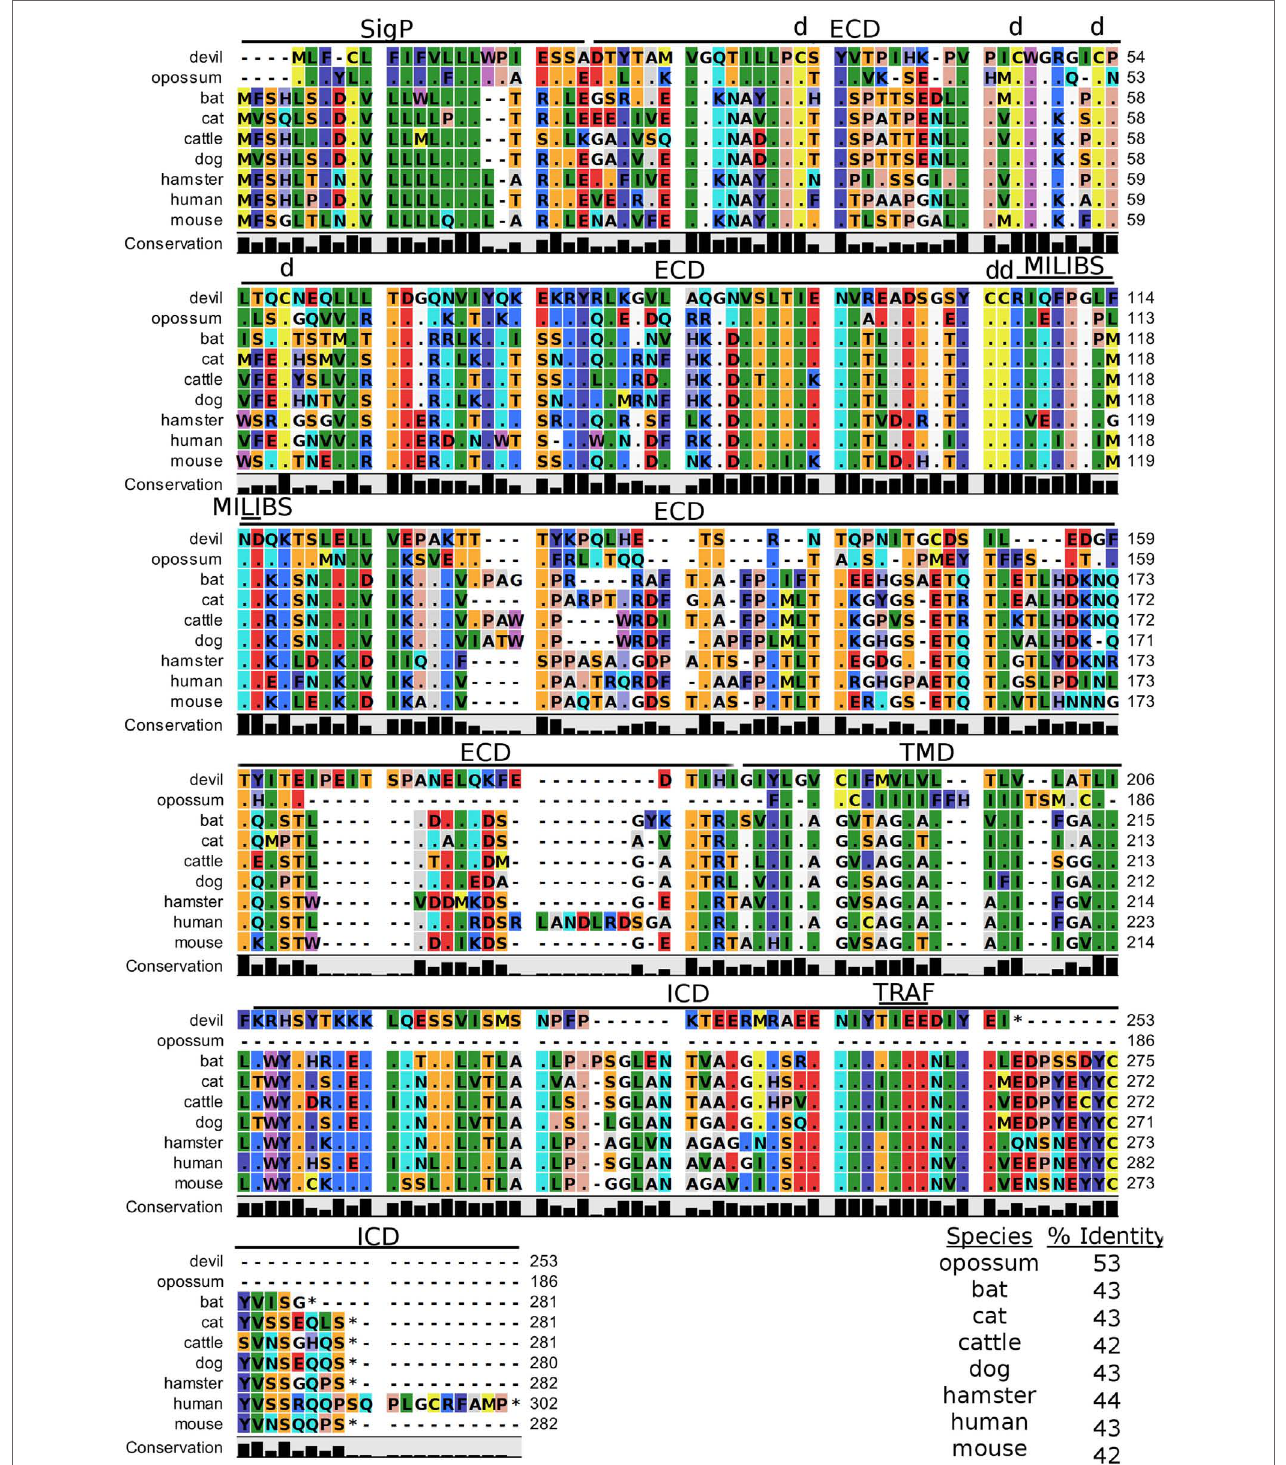
FigUre 10 | alignment of TiM-3 reference genes for nine species . The predicted signal peptides (SigP), extracellular domain (ECD), transmembrane domain (TMD), and intracellular domain (ICD) are demarcated with bars. “d” above the alignment represents predicted disulfide bonds. “TRAF” indicates a potential TRAF1/2-binding site and “MILIBS” demarcates a conserved metal ion-dependent ligand-binding site (MILIBS) found in phosphatidylserine on the surface of apoptotic cells. The black bar graphs below the alignment represent the conservation of amino acids across all nine species. The percent amino acid sequence identity between devils and other species is shown in the bottom right corner of the alignment.